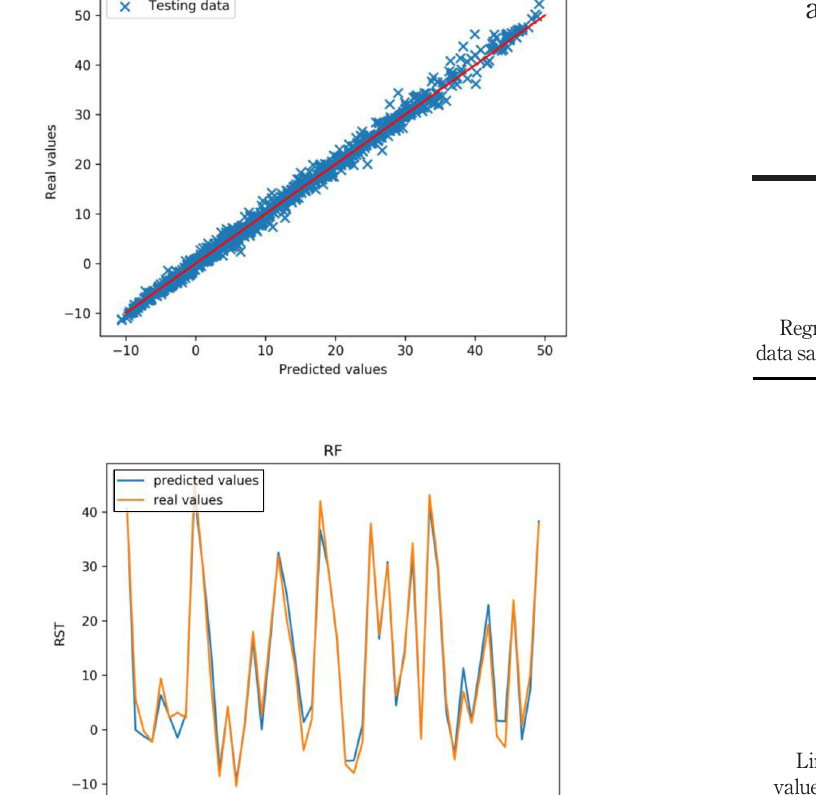
Figure 12. Line chart of real value and predicted value with RF